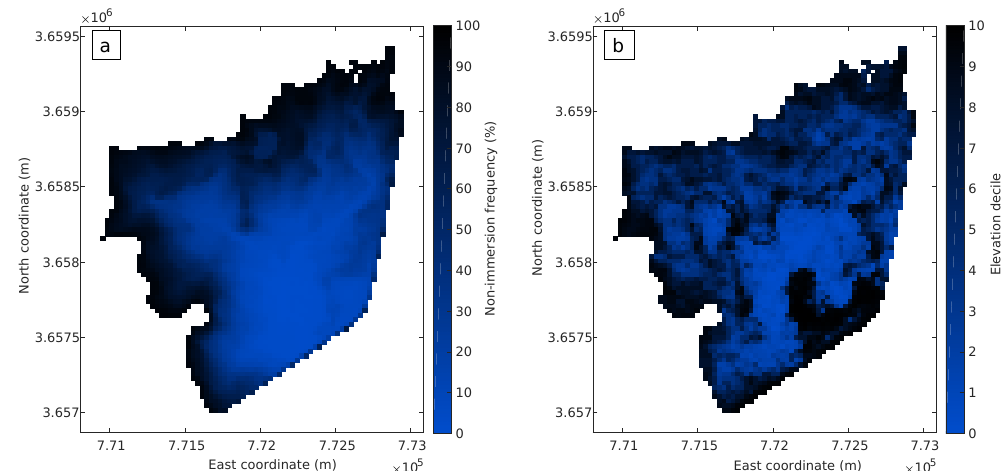
Figure 7. (a) Relative non-immersion frequency (1 − r p , from the 2-D classes) and (b) elevation (from the DEMs, in terms of decile) in the Kudnah reservoir. Coordinates are expressed in CRS WGS 84/UTM zone 36N.